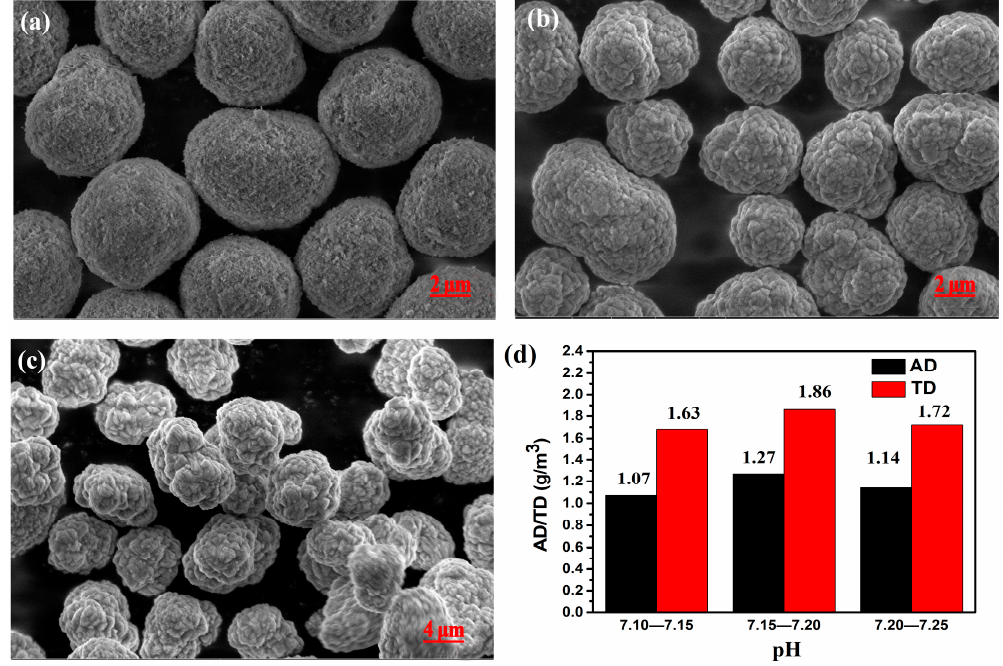
Figure 2. SEM images of CoCO 3 prepared under all pH ranges: ( a ) 7.10–7.15, ( b ) 7.15–7.20, and ( c ) 7.20–7.25. ( d ) AD and TD of CoCO 3 prepared under different pH ranges.